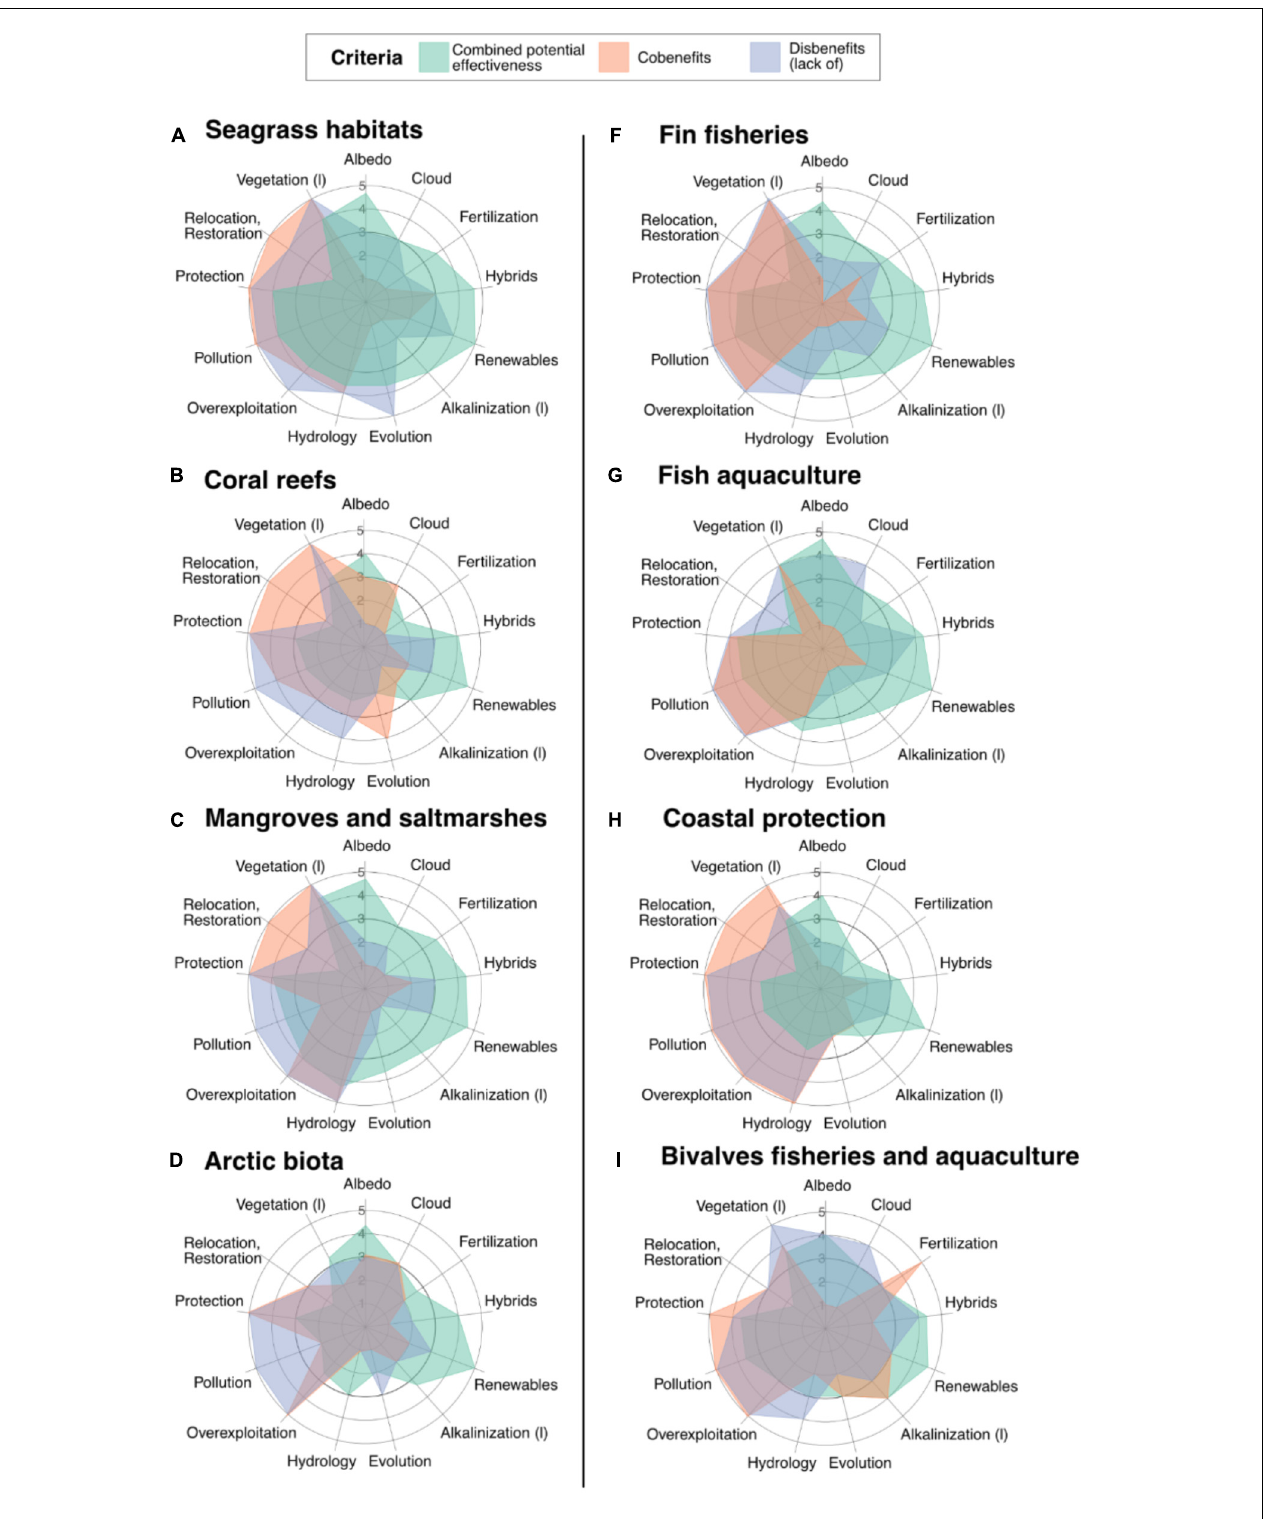
FIGURE 5 | Contribution of ocean-based solutions to reduce the impacts of key ocean drivers on key ecosystems (A–D) and ecosystem services (E–H) . The combined potential effectiveness represents the average potential effectiveness to reduce the impacts of ocean warming, ocean acidification, and sea-level rise (see section “SM3” of the Supplementary Materials ). Scores 1 to 5: very low, low, moderate (thicker circle), high, and very high.